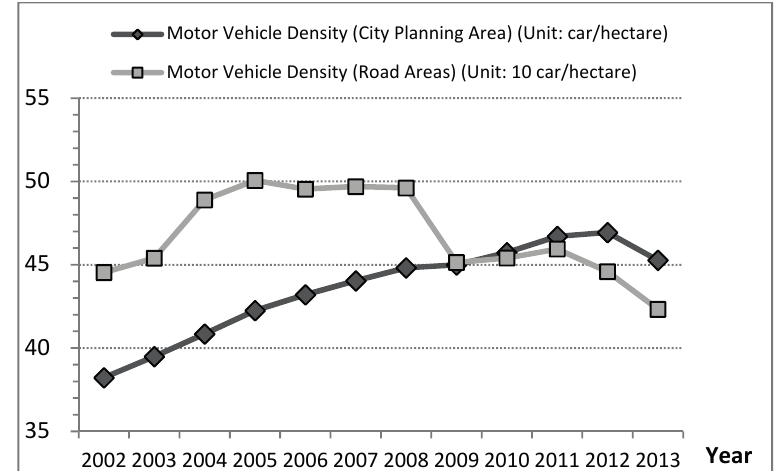
Figure 3. Trends for motor vehicle density, Taiwan’s cities, 2002 to 2013.